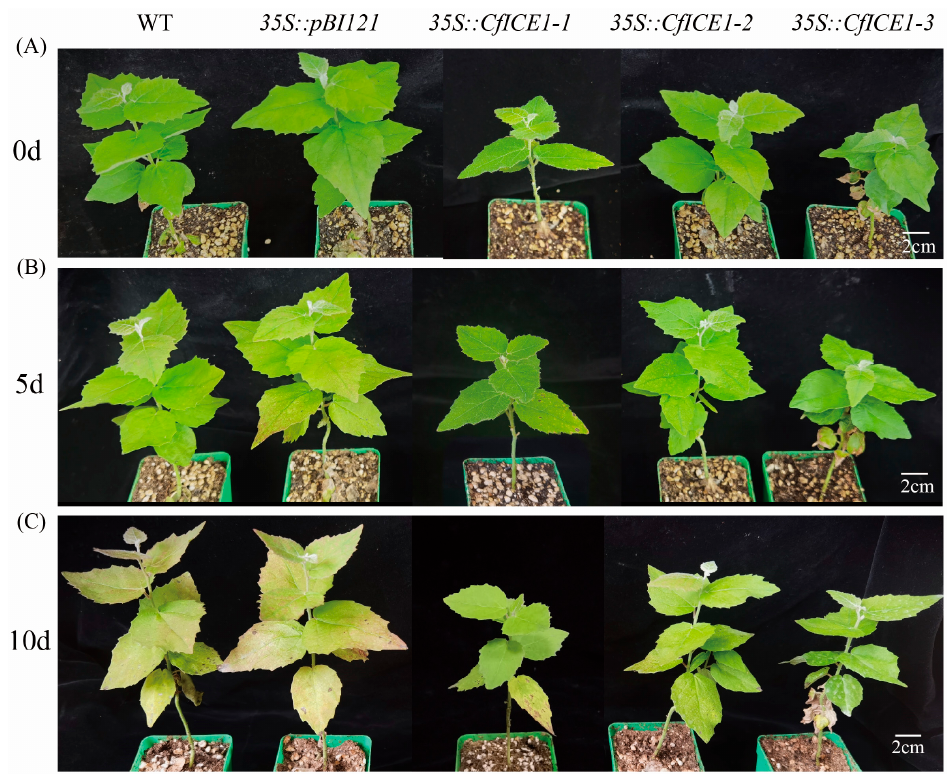
Figure 6. Phenotypic changes of transgenic, empty vector and wild-type poplar lines under ( A ) 0, ( B ) 5 and ( C ) 10 days of drought stress.